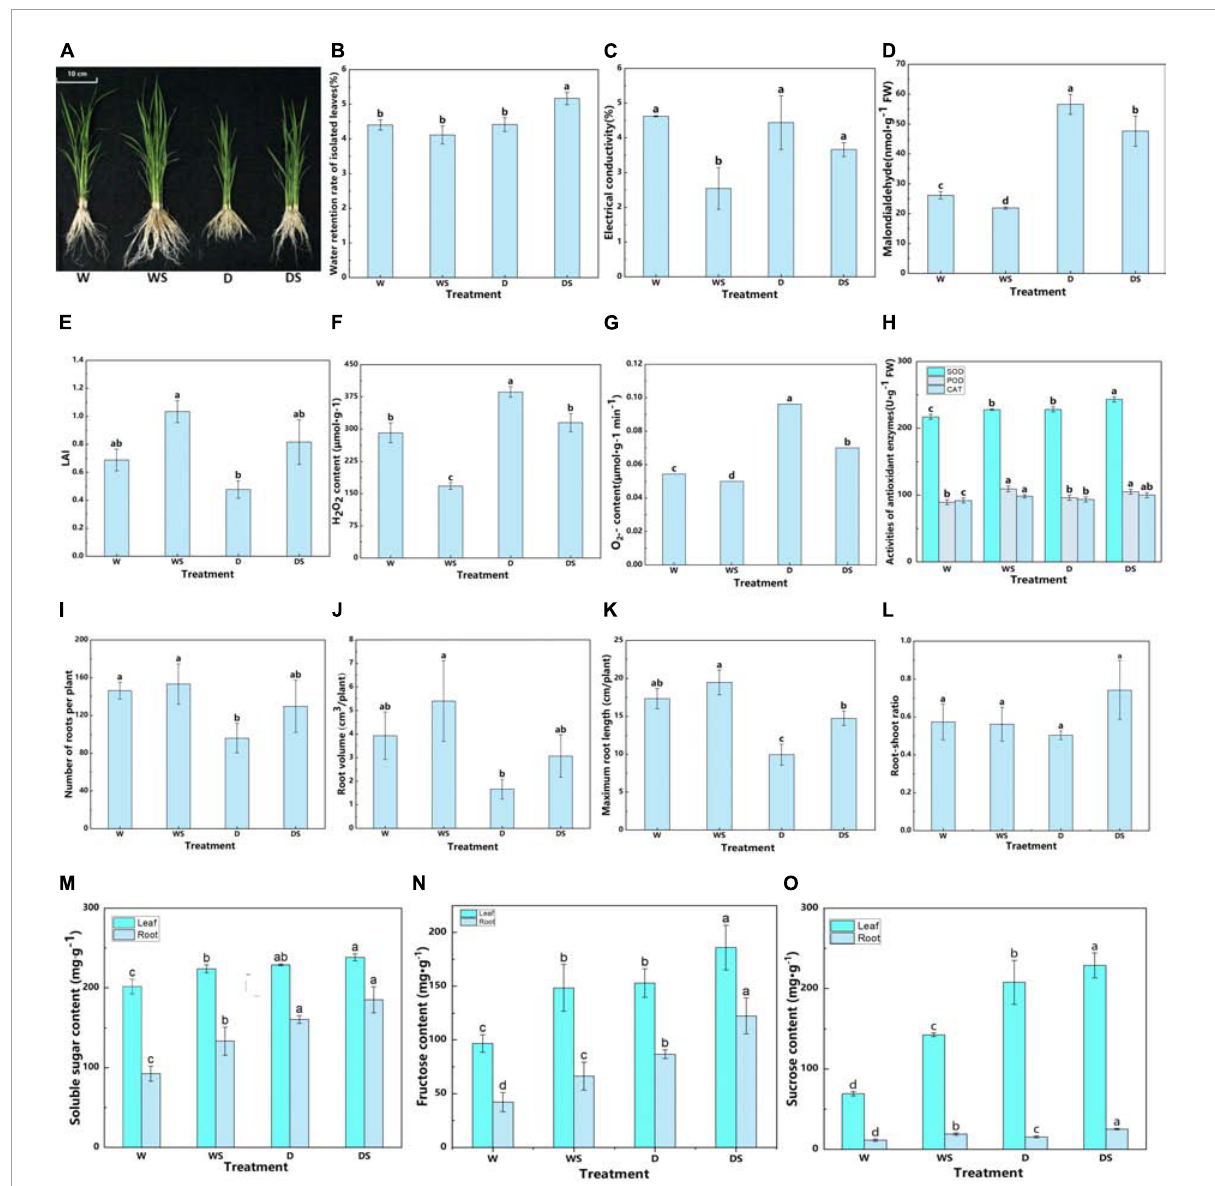
FIGURE1 Effect of silicon application on rice under two cultivation conditions. Phenotypes of rice with and without Si under flooding and dry cultivation conditions (A) ; Relative water retention rate (B) , electrical conductivity (C) , malondialdehyde (MDA) content (D) , leaf area index (E) , H 2 O 2 content (F) , O 2 − content (G) , and antioxidant enzyme activity (H) , root number (I) , root volume (J) , root length (K) , root to shoot ratio (L) , soluble sugar content (M) , fructose content (N) , and sucrose content (O) of rice. The panels (H,M–O) , different lowercase letters indicate unified indicators significant differences between different treatments. Each experiment was repeated three times. Data represented are the means ± SD of three biological replicates. Different lowercase letters indicate significant differences ( P < 0.05). W: Rice under